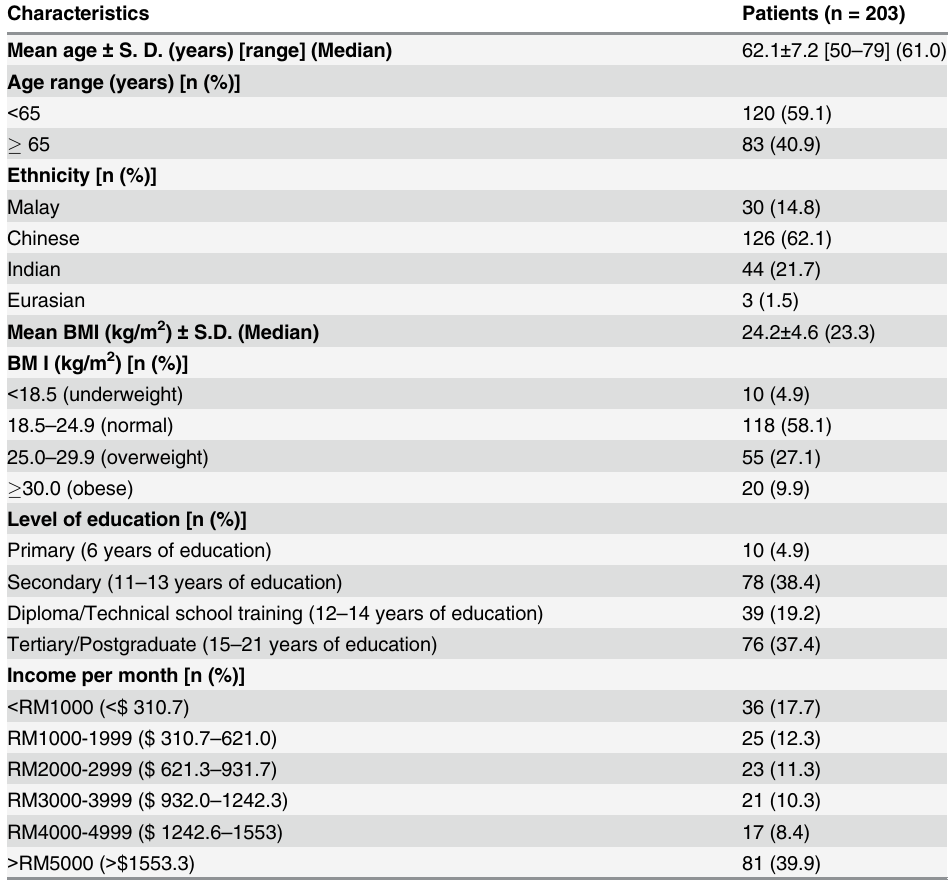
Table 1. Baseline demographic characteristics of